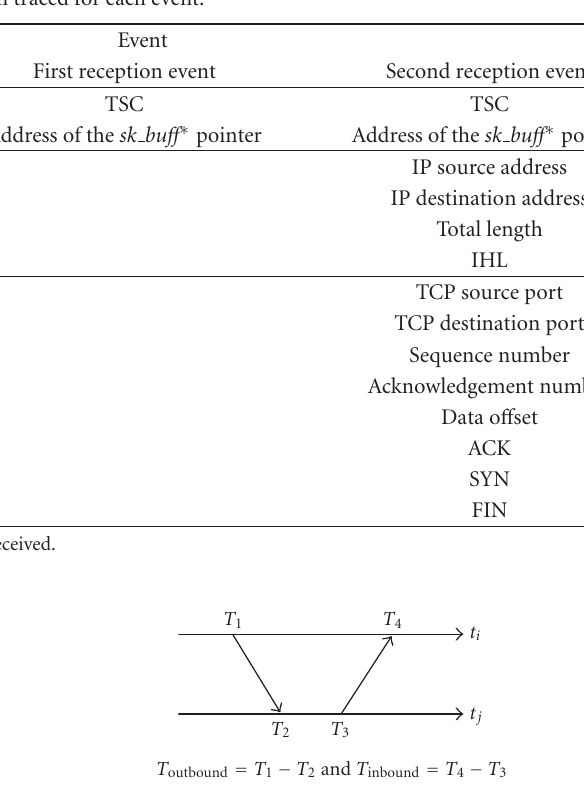
Figure 1: Round trip time between two nodes i and